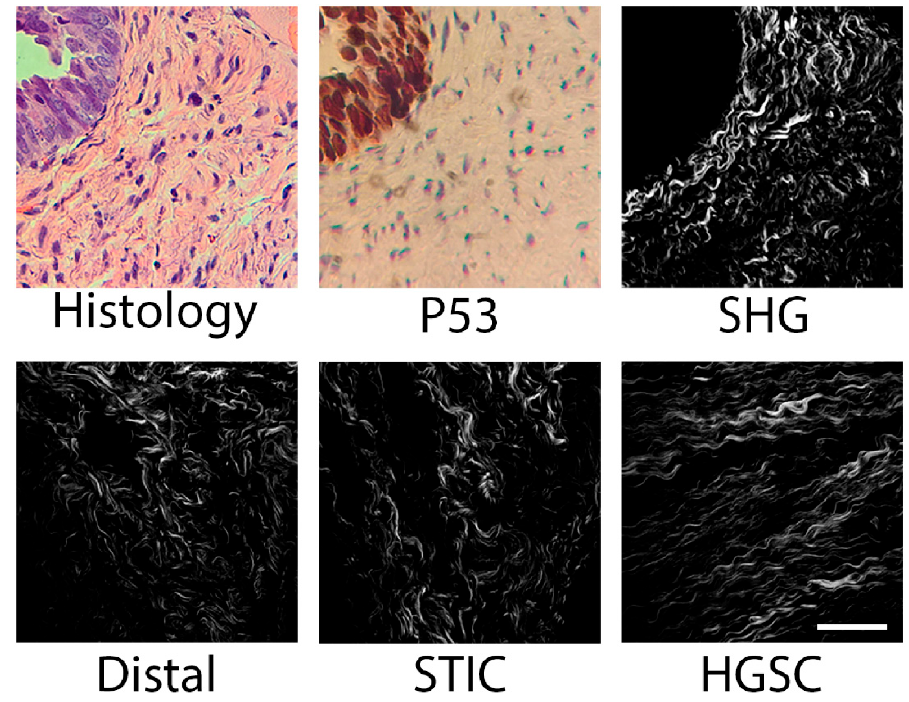
Figure 2. Histology and p53 stained slides were used to select regions of interest for SHG imaging. p53 stains for TP53 mutations, which are indicative of serous tubal intra-epithelial carcinomas (STIC) areas. The top row shows the H&E stain, p53 stain and SHG from the same STIC region. The bottom row shows examples of SHG images of distal, STIC, and high-grade disease in the FT used in the image analysis. Scale bar = 50 microns.